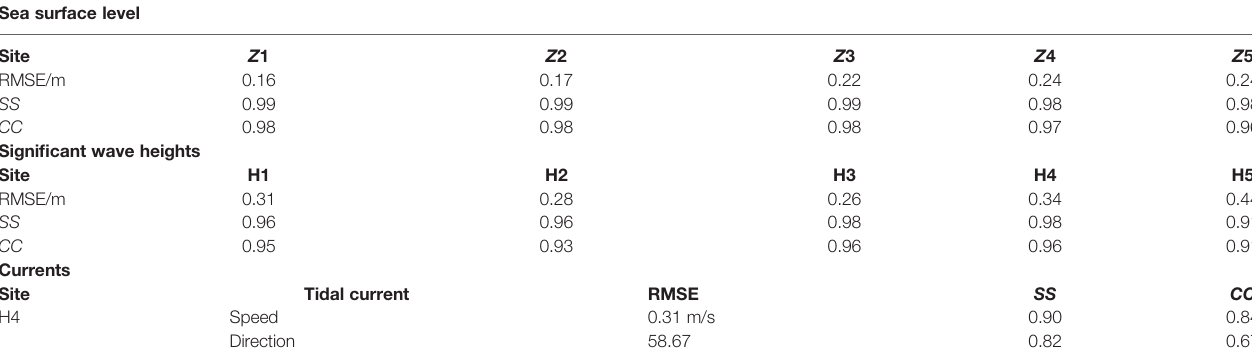
TABLE 4 | Statistics of tide level veri fi cation during the typhoon. Sea surface level